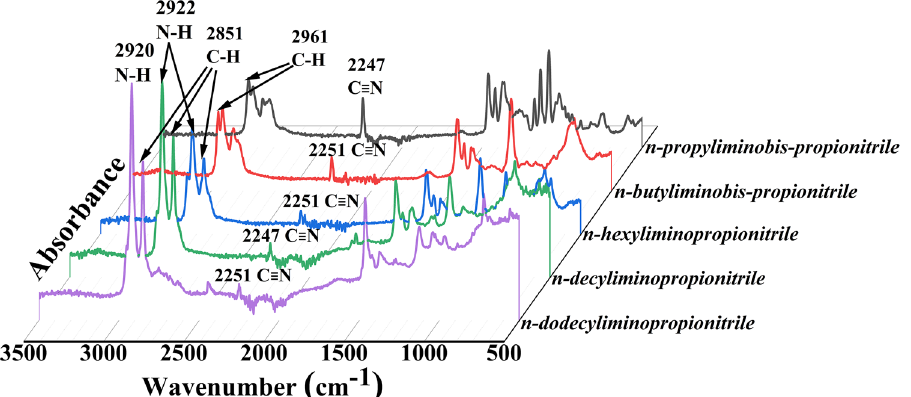
Figure 2. FTIR spectra of acrylonitrile